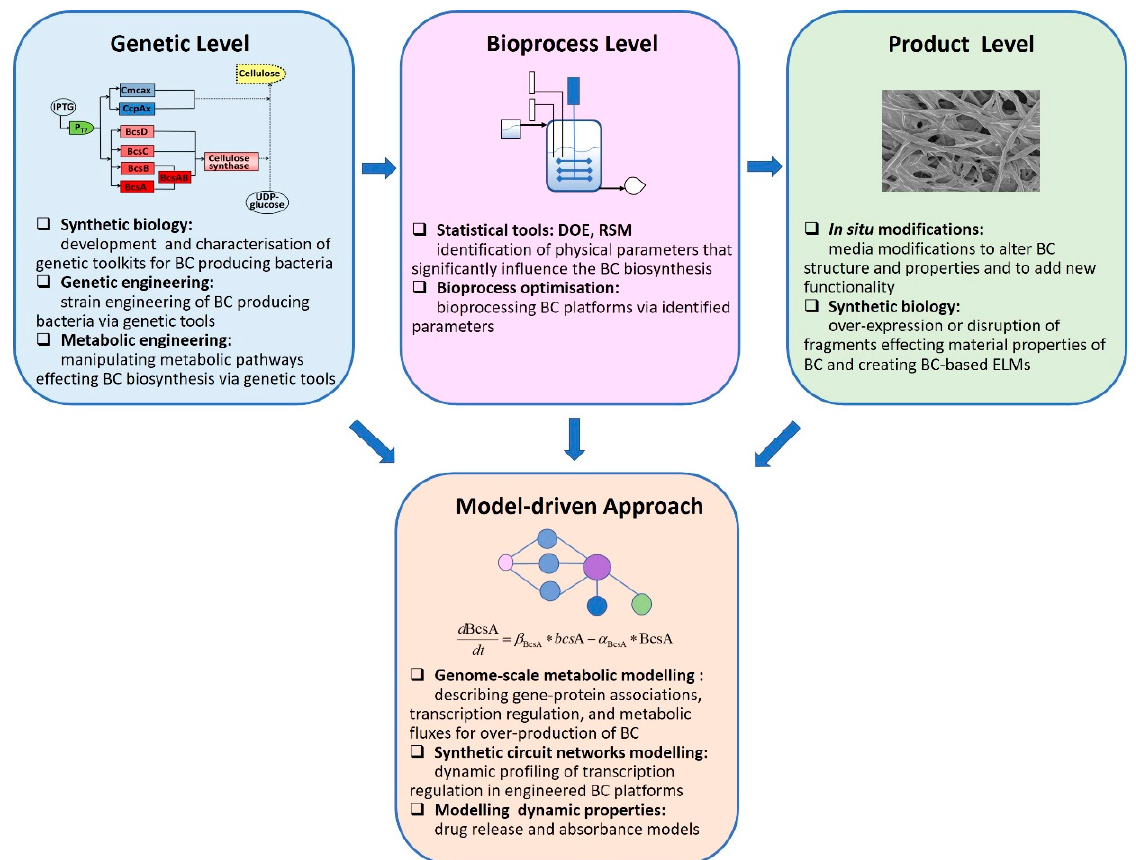
Figure 1. Summary of recent research focusing on BC biosynthesis platforms.